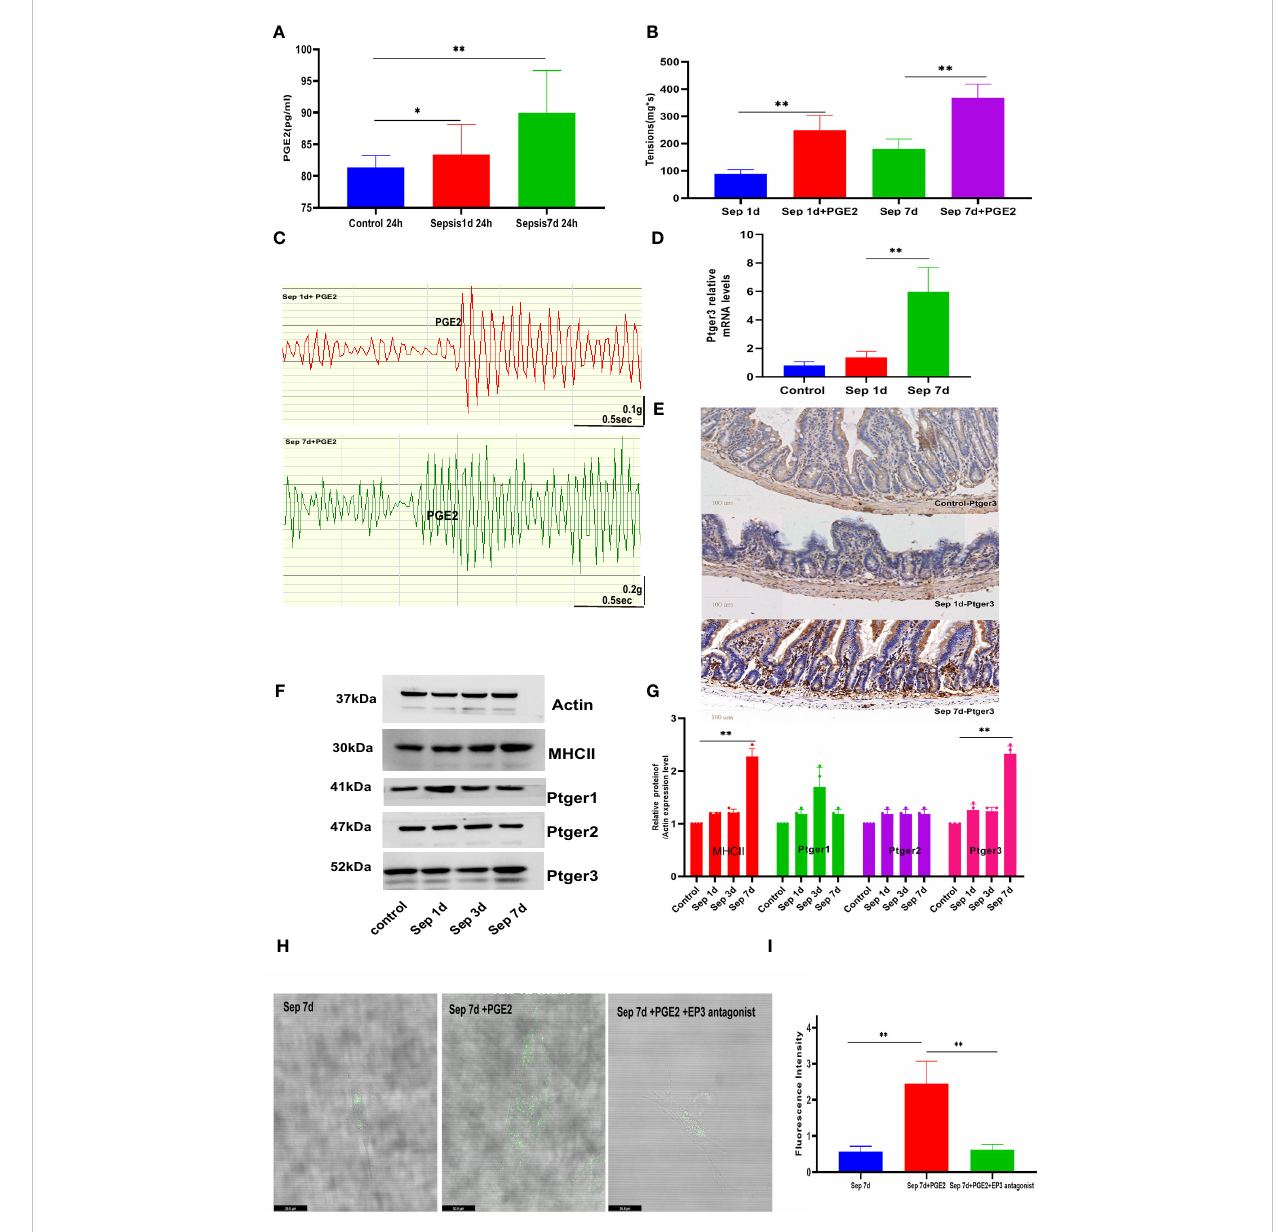
FIGURE 3 Macrophage-mediated small intestine contraction is prostaglandin E2 (PGE2)-dependent (A) Compared sepsis 7 days in mice to sepsis 1 day, PGE2 release from M Μ f s increased in response to GSK101(TRPV4 agonist) stimulation. (B, C) Exogenous PGE2 increased the spontaneous contraction force and histogram of the statistical. (D, E) Changes in intestinal muscularis Ptger3 mRNA levels and intestinal transverse Ptger3 immunohistochemical staining after control, KP sepsis 1 day and KP 7 days. (F, G) E-prostaglandin receptor (EP1 – EP3) protein expression was measured by western blotting and histogram of statistical analysis. (H, I) The effects of PGE2 and ptger3 antagonists on primary smooth muscle were determined by fl uorescence analysis using the fl uorescent probe Fluo-4 and histogram of fl uorescence intensity statistical analysis. Differences between groups were signi fi cant at a P value of <0.05. * Represents p <0.05, ** represents p <0.01, and *** represents